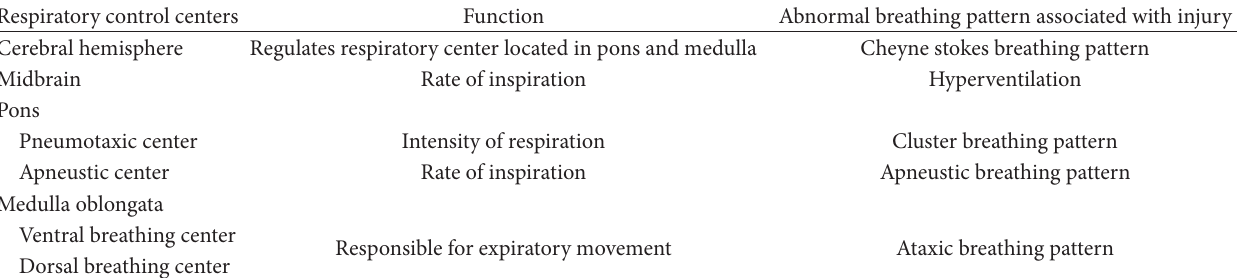
Table 1: Neurologically driven breathing patterns and anatomic